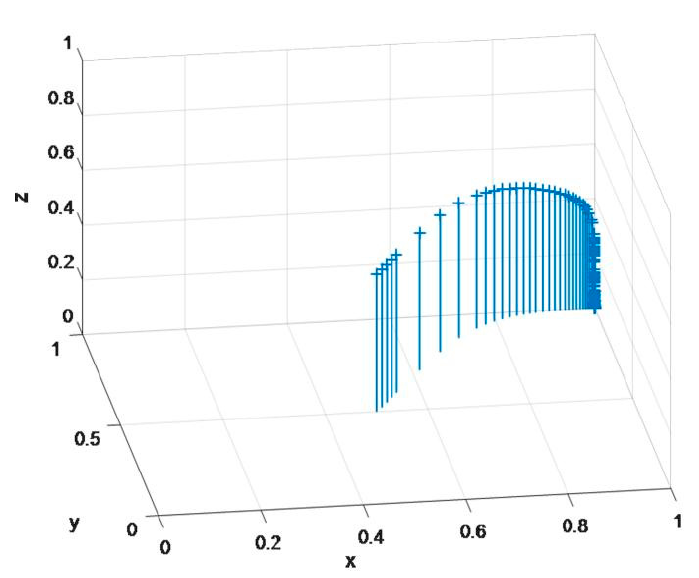
Figure 10. Three-dimensional diagram of evolutionary path at stable point (1, 1, 0).